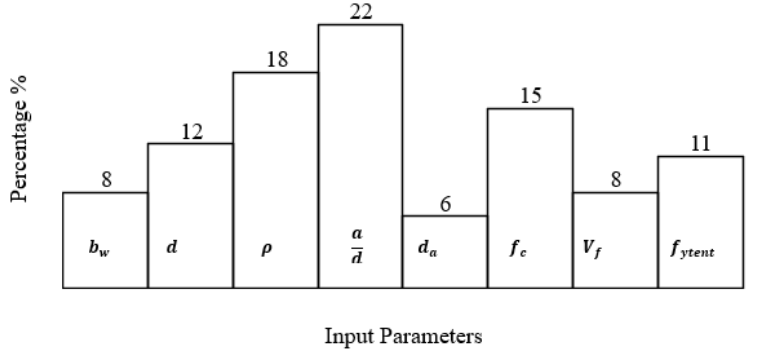
Figure 9. Contribution of input parameters in the proposed GEP model.